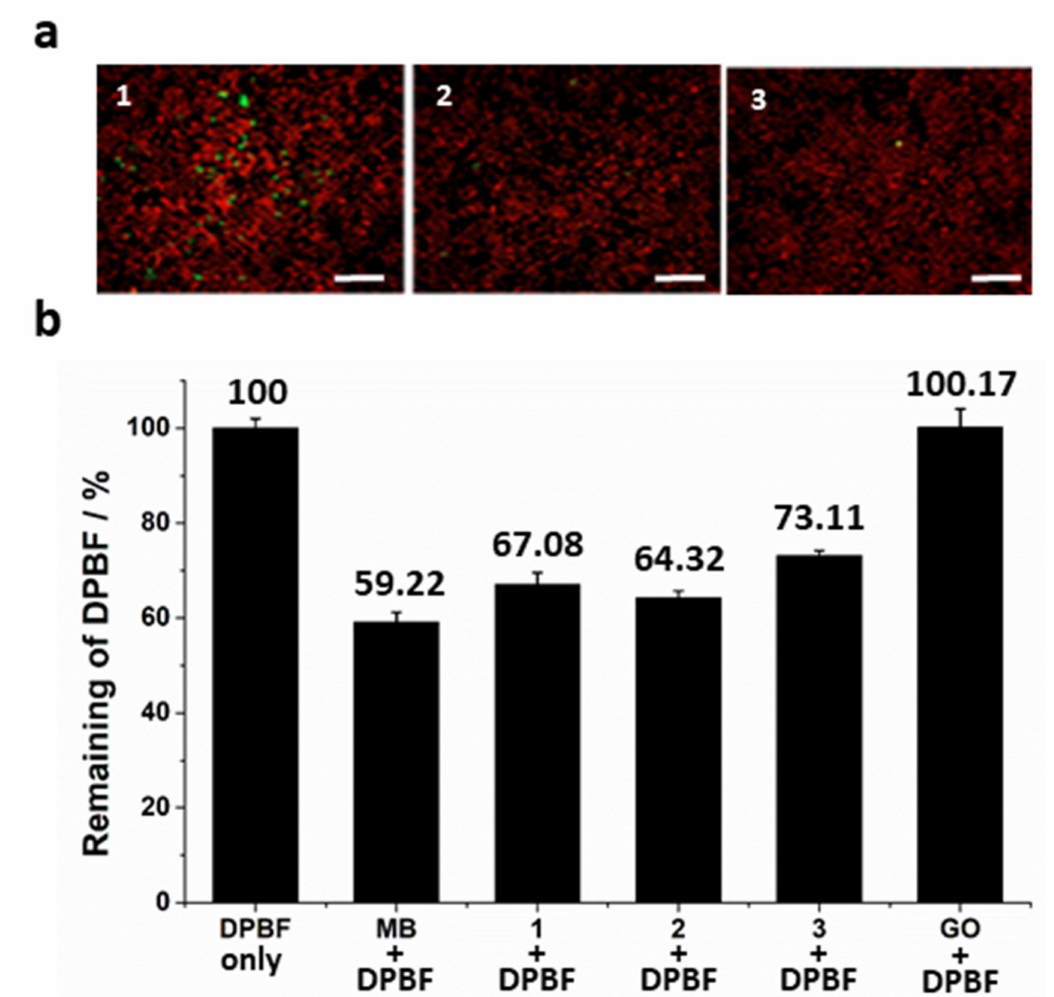
Figure 6. ( a ) Fluorescence images of live (green) / dead (red) cells stained with calcein acetoxymethyl (AM) / propidium iodide (PI) after photoirradiation followed by 3 h incubation with 1 , 2 , and 3 . The concentration of each PS was 1 µ M. Bars, 100 µ m. ( b ) 1,3-Diphenylisobenzofuran (DPBF) absorbance decay (%, 50 µ M in DMSO) at 418 nm after photoirradiation (total light dose 2 J · cm − 2 ; irradiation time 15 min) in the absence (control) and presence of 1 µ M 1 – 3 , GO, and methylene blue (MB) (with no tumor cells). Error bars represent the standard deviation of three replicate